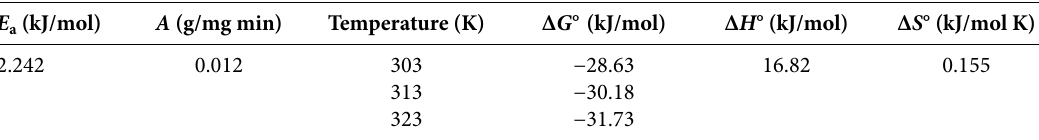
Table 7. Thermodynamic parameters for MB adsorption by SA-RPB